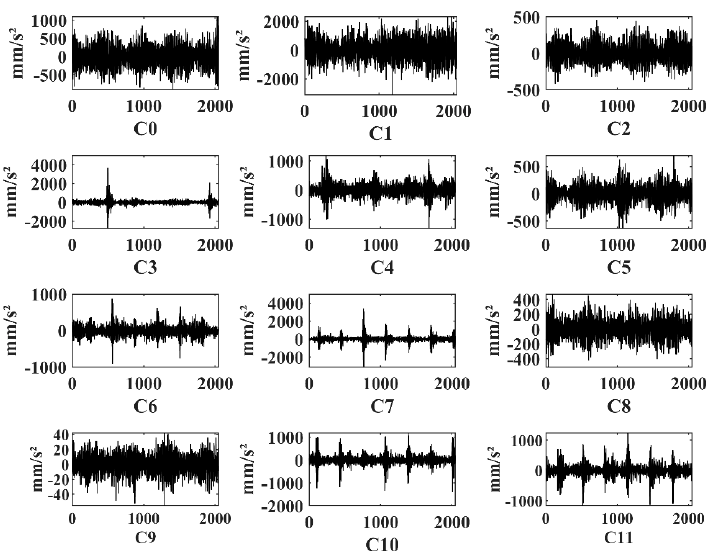
Figure 7. Gears and bearings with different defects.